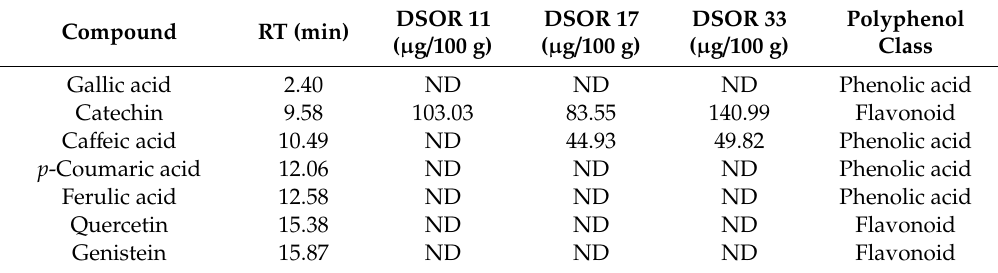
Table 5. Quantification of polyphenolic compounds in decorticated sorghum extracts by high performance liquid chromatography photodiode array